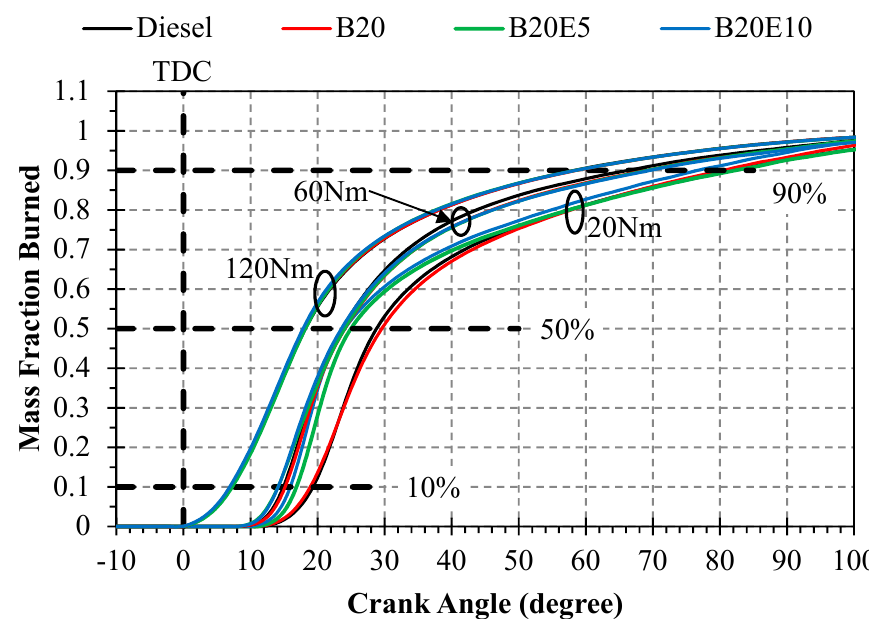
Figure 9. Variation in mass fraction burned for all tested fuels at an engine load of 20 Nm, 60 Nm, and 120 Nm.